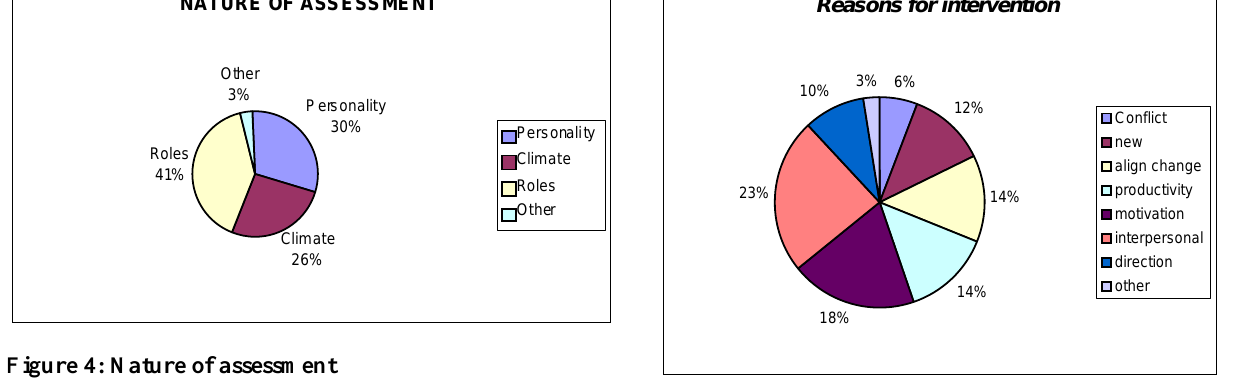
Figure 6: Reasons for